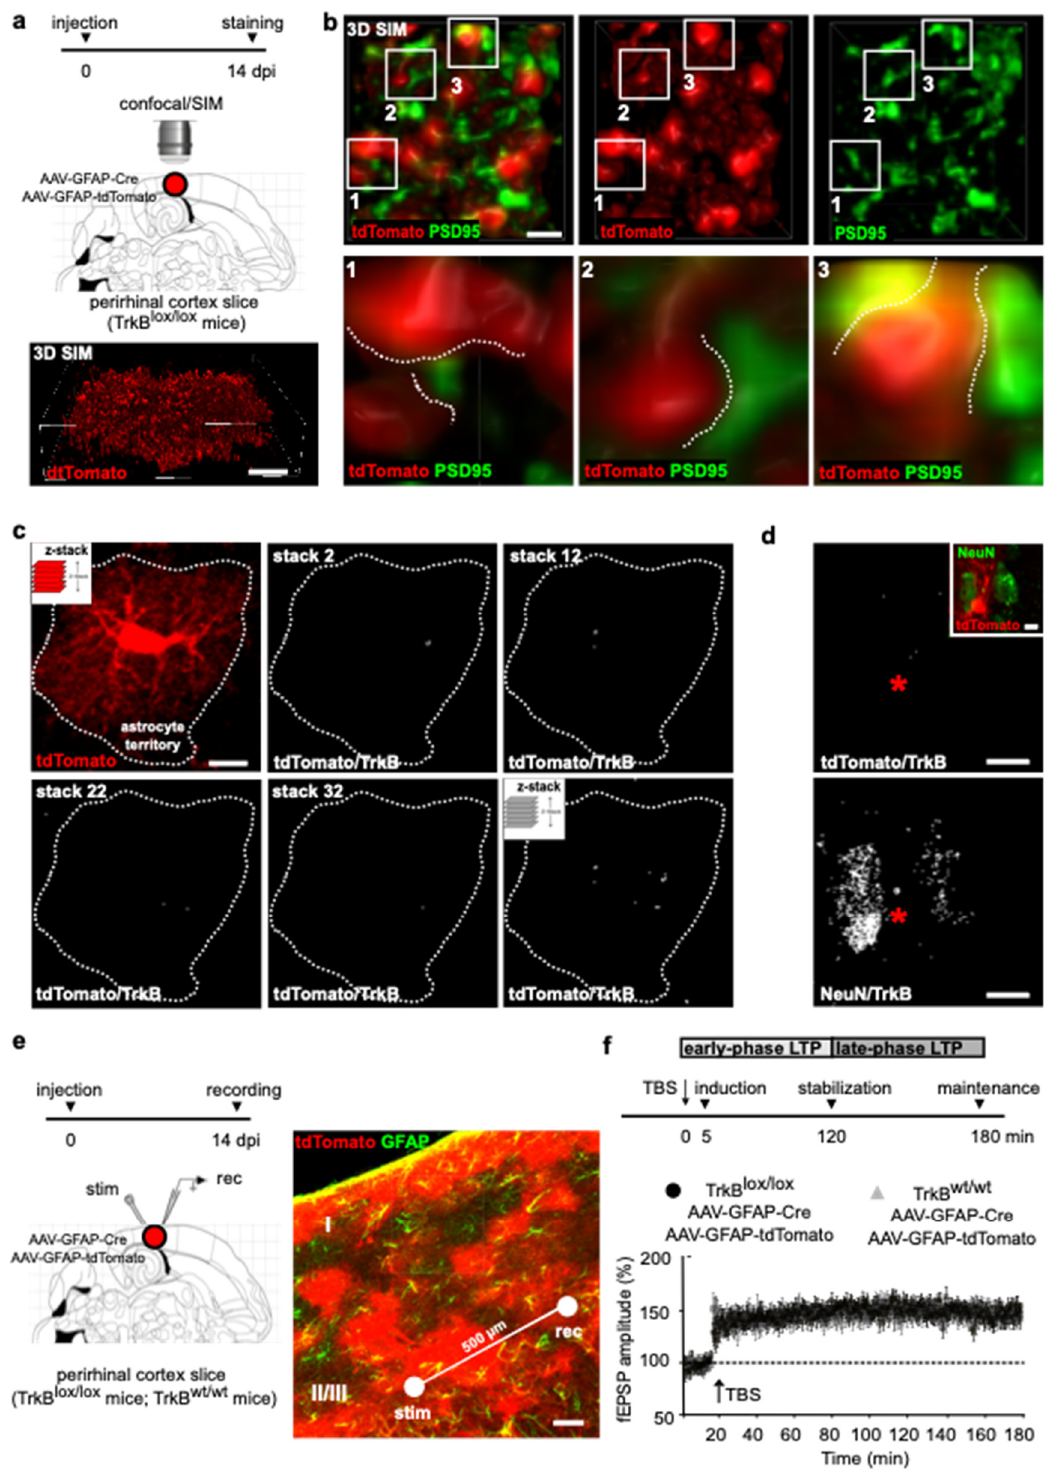
Figure 1. LTP evoked in cortical slices from TrkB lox/lox mice injected with AAV-GFAP-Cre. ( a ) Schematic diagram depicting the experimental paradigm (upper). TrkB lox/lox mice were double-injected with AAV-GFAP-Cre and AAV-GFAP-tdTomato in layers II/III of the perirhinal cortex and slices were prepared for immunostaining 14 dpi. Three-dimensional-SIM reconstruction of an astrocyte labeled with tdTomato (lower). Scale bars: 10 µm. ( b ) Upper panels show astrocyte microdomains labeled by tdTomato near post-synaptic sites labeled by PSD95 (left). Individual tdTomato (middle)